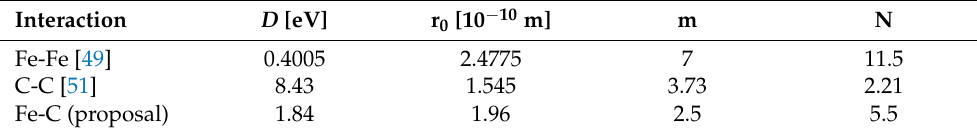
Table 1. The MLJ potential parameters for interactions of Fe-Fe, C-C and Fe-C. Interaction